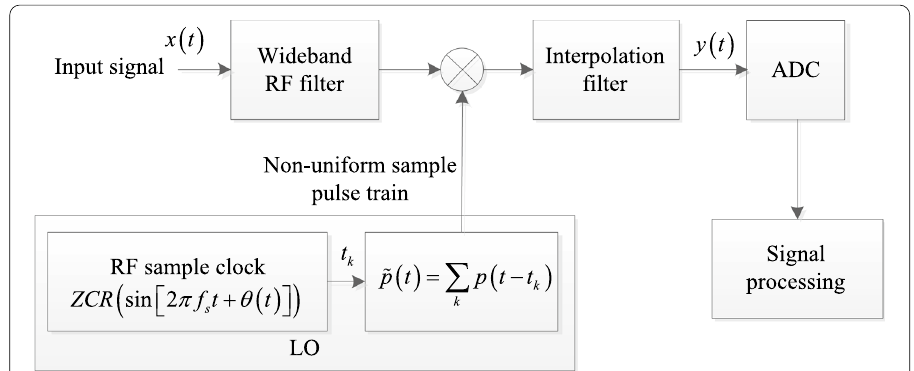
Fig. 1 Modulated sampling